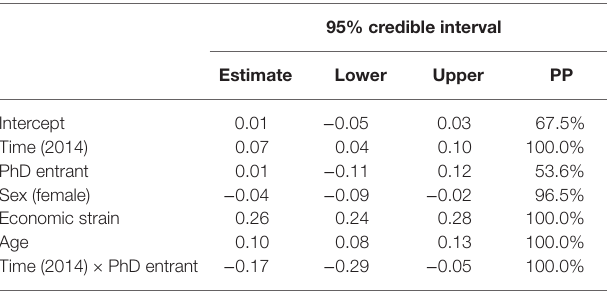
TABLE 1 | Fixed effects from multilevel Bayesian regression with 95% credible